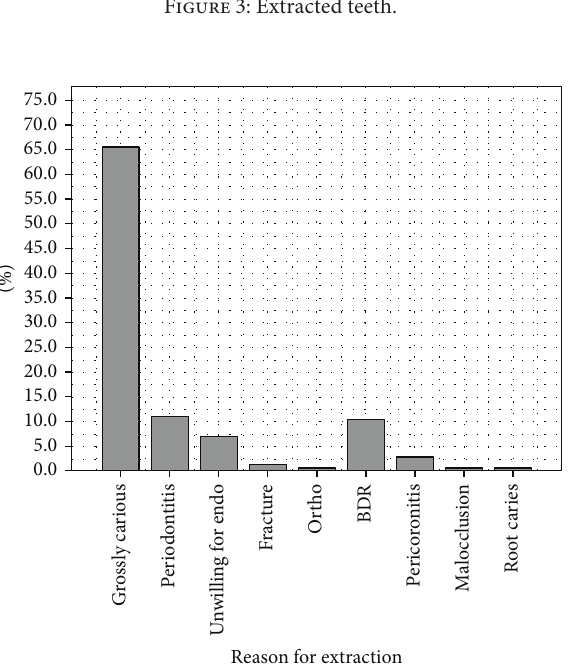
Figure 3: Extracted teeth.